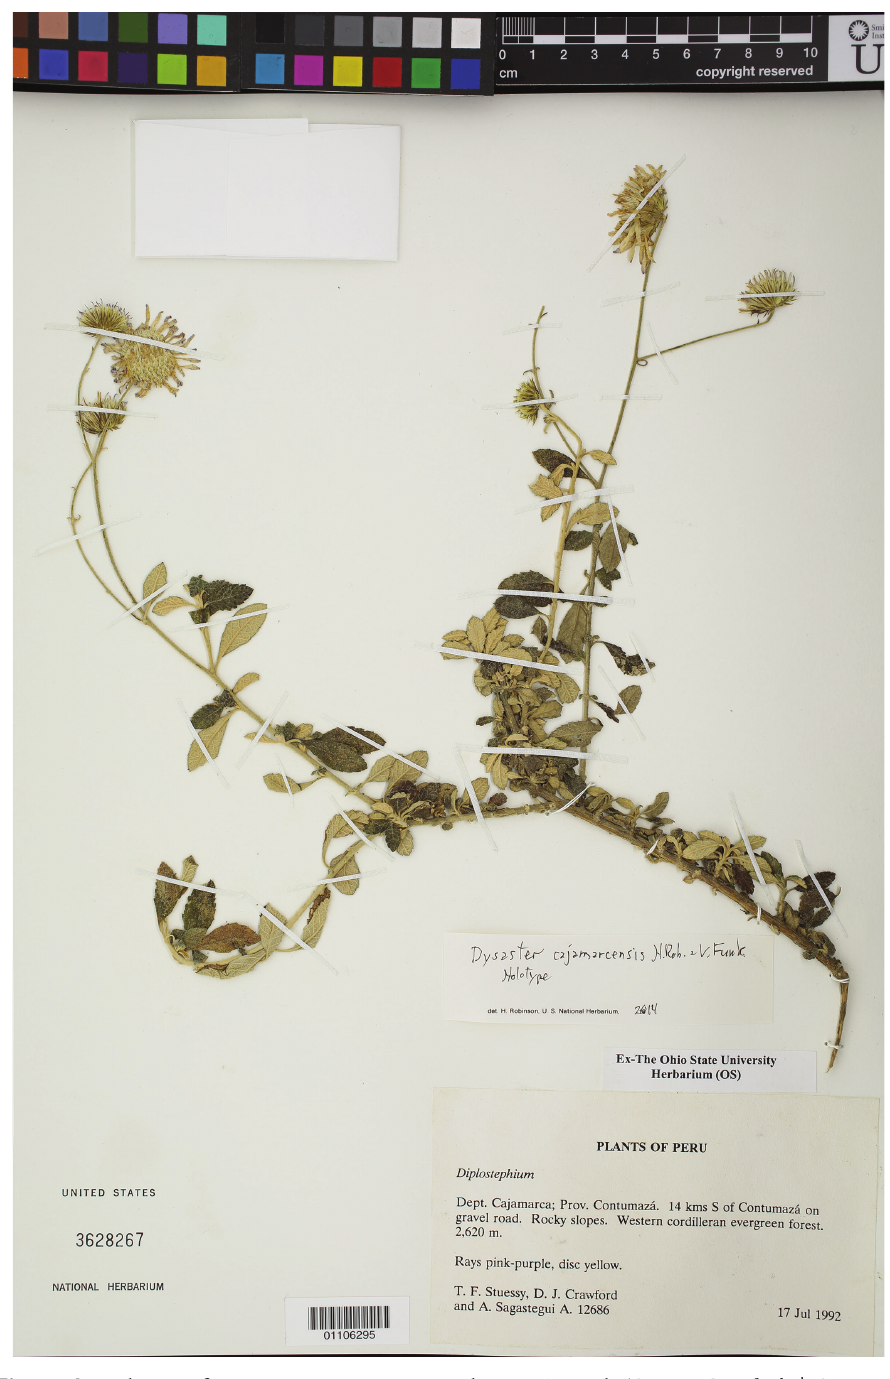
Figure 1. Holotype of Dysaster cajamarcensis H. Rob. & V.A. Funk ( Stuessy, Crawford & Sagastequi 12686 ,